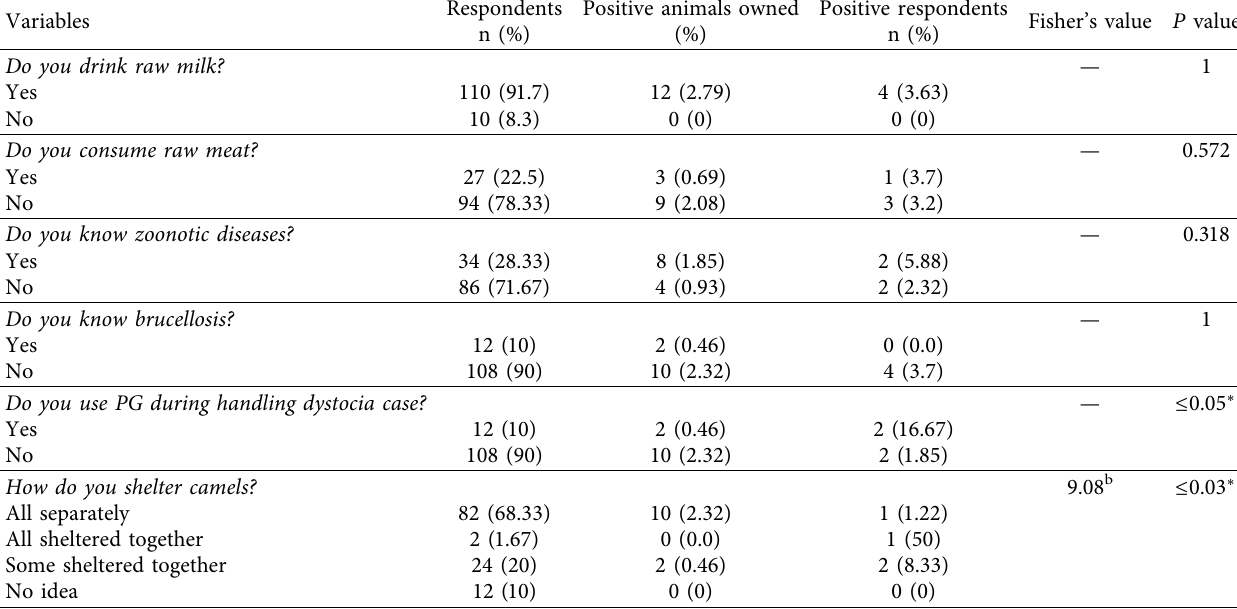
Table 7: Association of knowledge and practice of the camel owners with Brucella seropositivity.